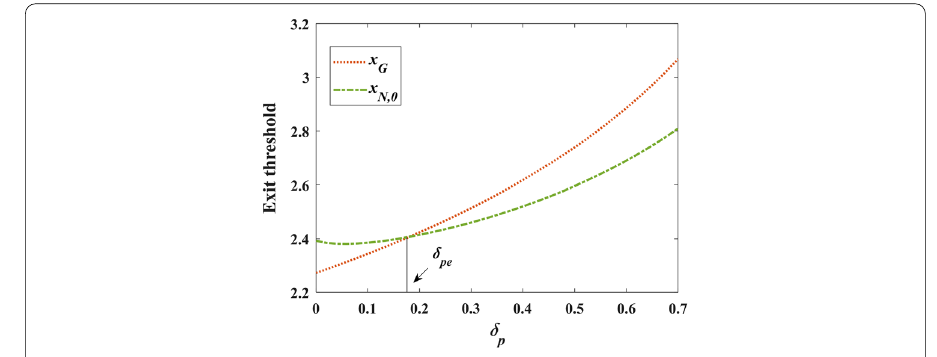
Fig. 5 Exit thresholds change with the reduction factor δ p under (cid:31) f = (cid:31) pN =